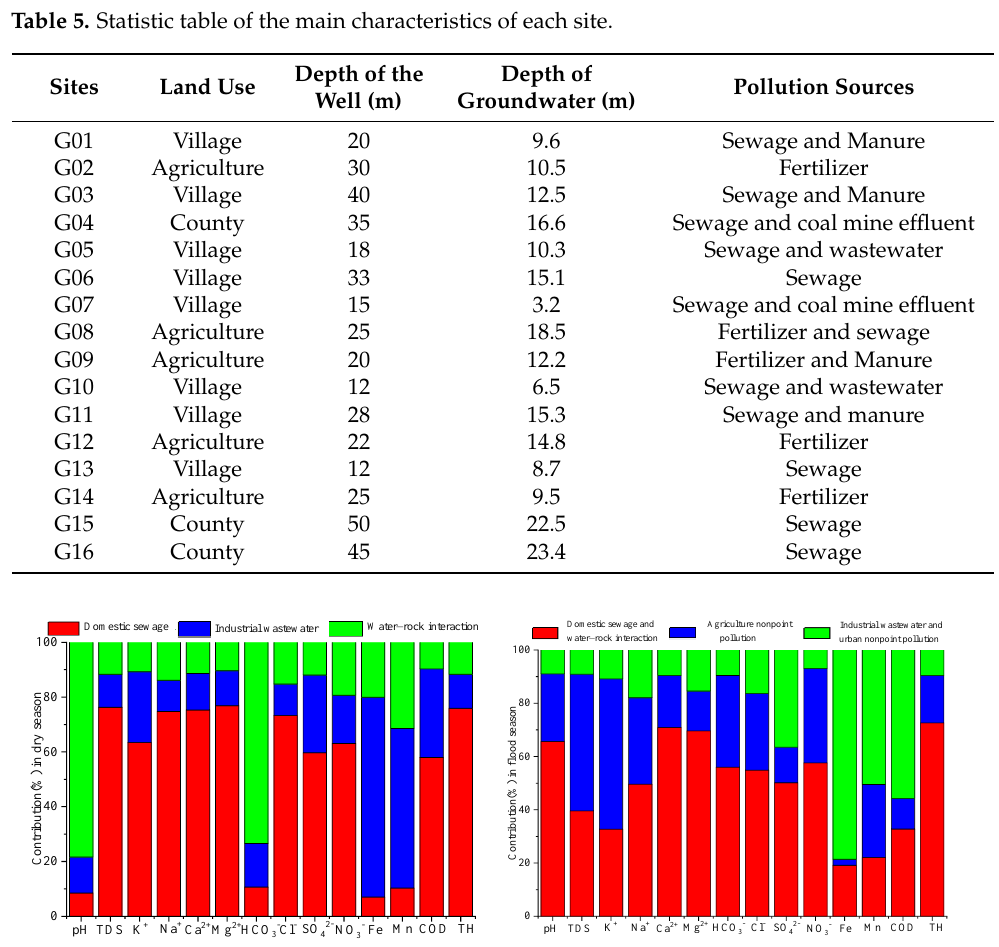
Figure 5. Source contribution (in %) of each variable in the dry and flood seasons in the Ye River basin.